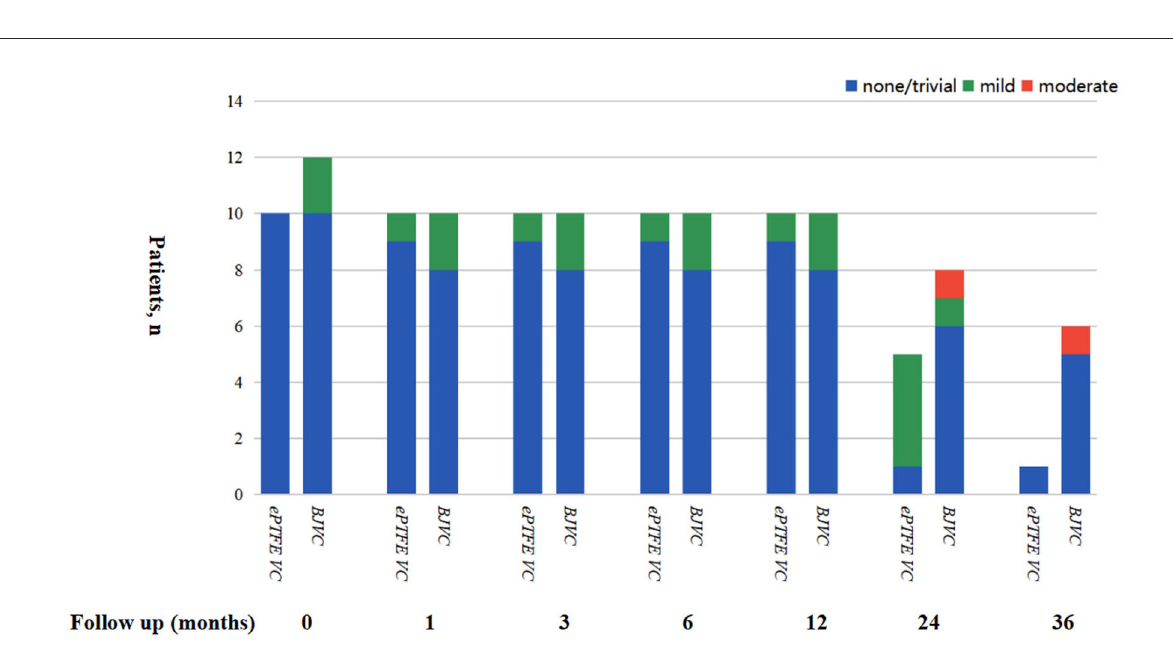
FIGURE4 Right ventricular outflow tract regurgitation rate in this cohort during